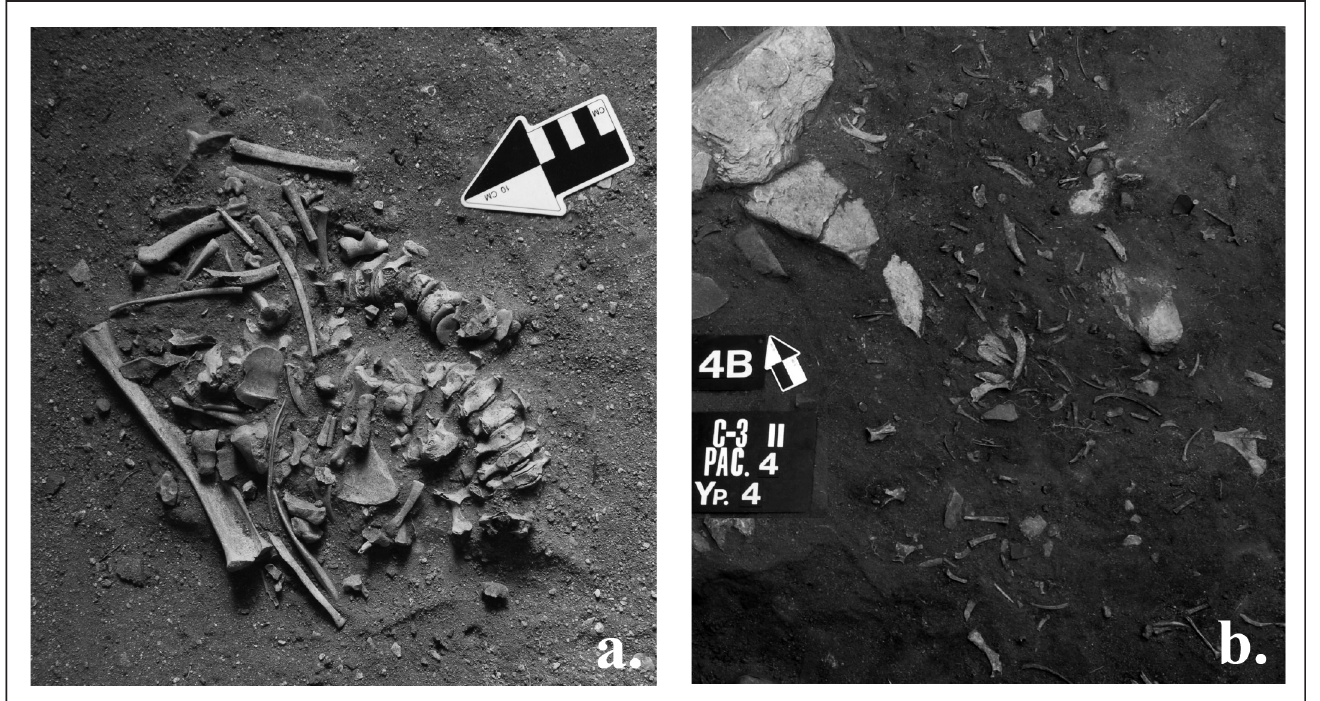
Fig 9. Example of seal bone clusters found at Sagan-Zaba II (a — layer VB, b — layer IVA). Photographs by A.